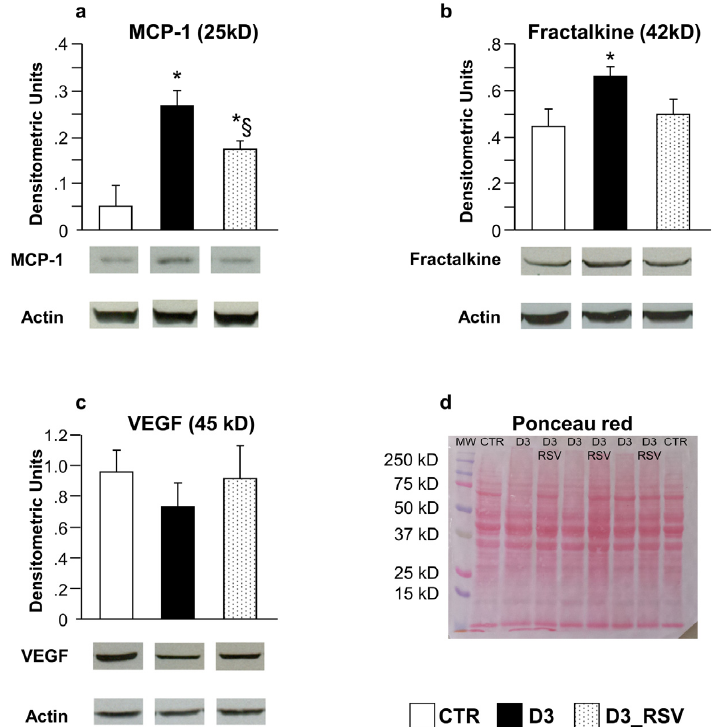
Figure 3. RSV-treatment reduced diabetes-induced tissue inflammation. Mean values ± SEM of MCP-1 ( a ), Fractalkine ( b ) and VEGF ( c ) expression levels in LV myocardium of control (CTR), diabetic (D3) and RSV-treated diabetic rats (D3_RSV), after three weeks of hyperglycemia (Western blot assay). Quantitative comparisons were performed on data derived from different gels processed in parallel (see Methods). Sets of bands related to cytokine expression of three animals representative of the average behavior observed in each group are reported at the bottom of the corresponding graph. Lanes were not adjacent in the gel, as indicated by the white space between them. The visualization of all proteins in one membrane stained with Ponceau Red is reported in ( d ), together with the molecular weights. * p < 0.05 vs. CTR, § p < 0.05 significant differences between D3 and D3_RSV (Kruskal-Wallis analysis of variance and Mann Whitney